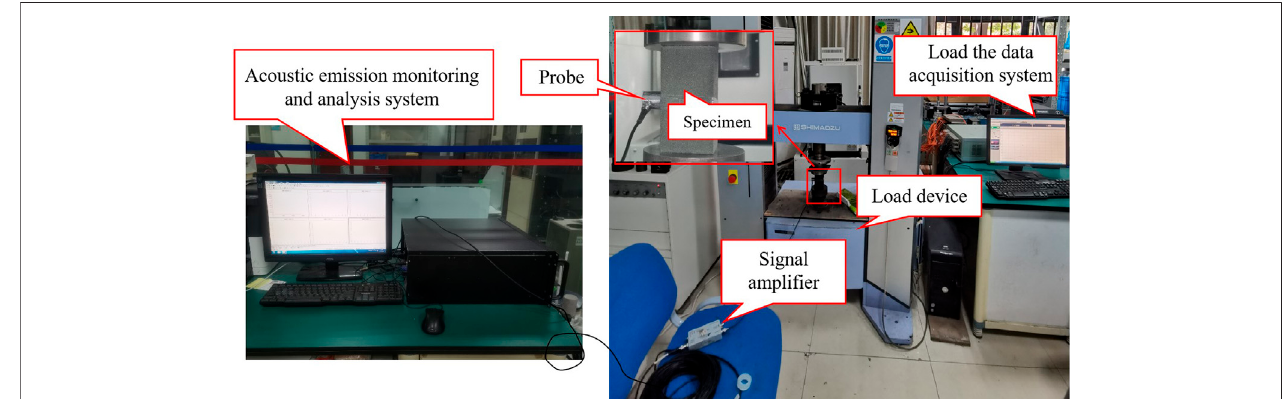
FIGURE 5 | Acoustic emission test system.